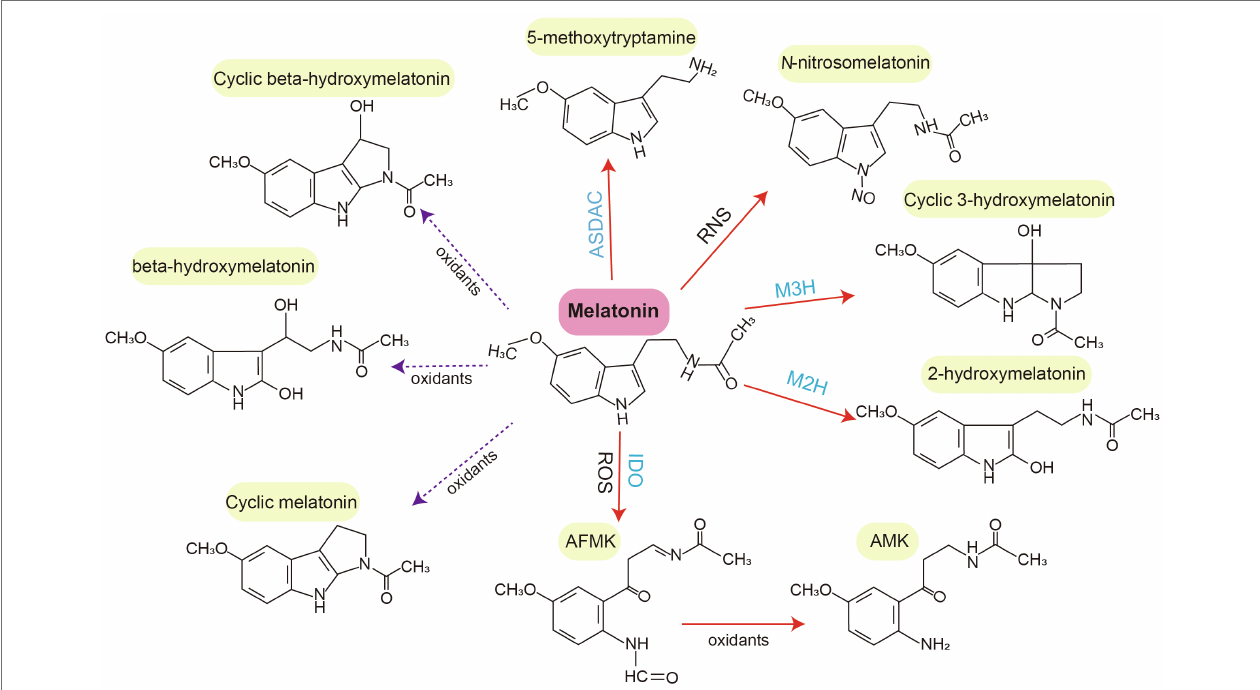
FIGURE 2 | Degradation (catabolism) of melatonin in plants. Melatonin is typically degraded into various metabolites through enzymatic (M3H, M2H, ASDAC, and IDO) and non-enzymatic (oxidants, ROS, and RNS) transformation routes. Red solid arrows indicate confirmed melatonin metabolites. Purple broken arrows indicate potential melatonin metabolites. AFMK, N1-acetyl-N2-formyl-5-methoxykynuramine; AMK, N-acetyl-5-methoxykynuramine; IDO, indoleamine 2,3-dioxygenase; M2H, melatonin 2-hydroxylase; M3H, melatonin 3-hydroxylase; and ASDAC, N-acetylserotonin